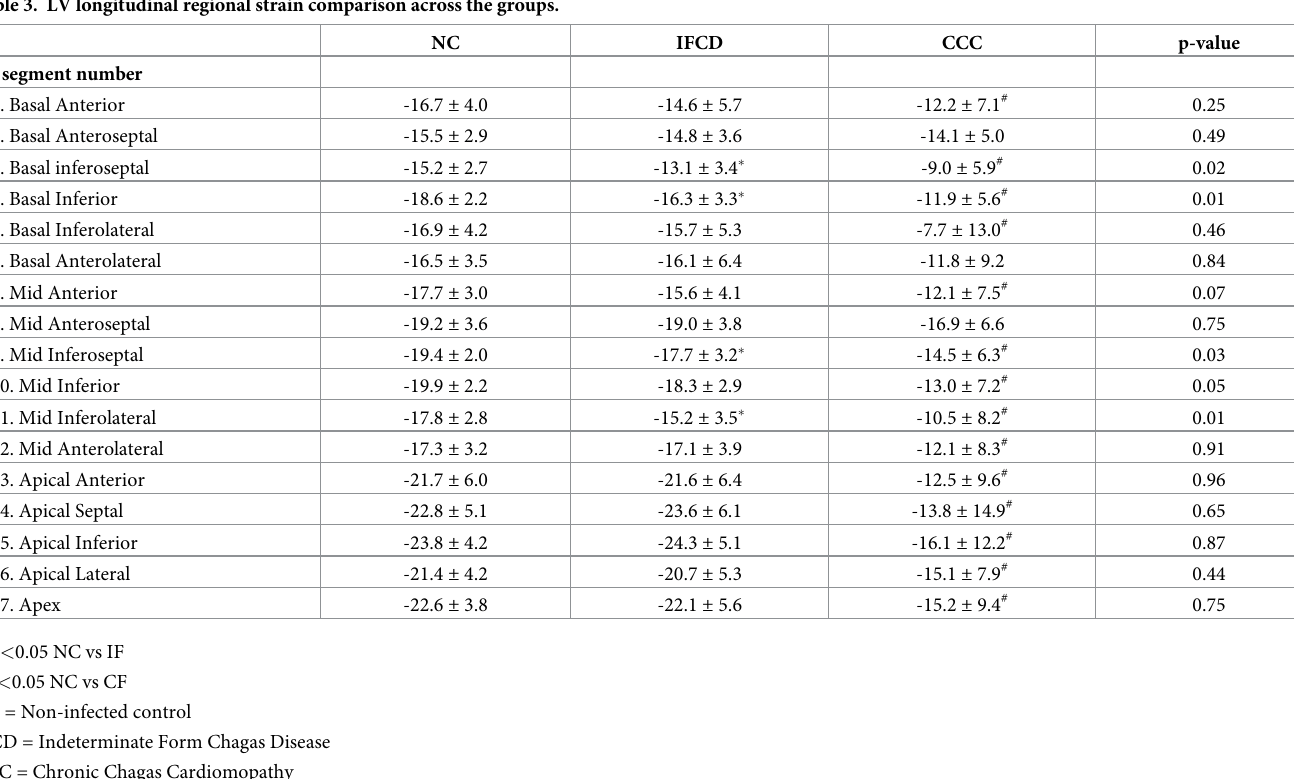
Values for intra-observer variability of GLS, GCS, GRS and twist were assessed by intra-class correlation coefficient (ICC) as follows: 0.99, 0.90, 0.86 and 0.97. ICC for inter-observer Table 3. LV longitudinal regional strain comparison across the